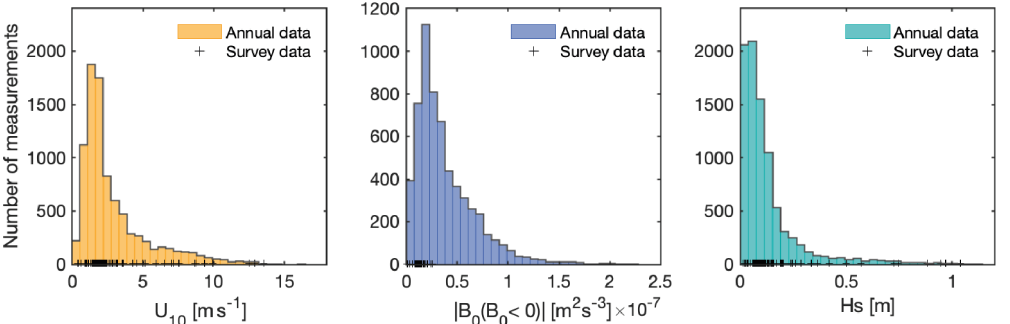
Figure 3. The annual distribution of the three main components used to compute k 600 models: wind speed at 10m (orange), buoyancy flux at the surface during cooling (blue), and significant wave height (turquoise). These survey data observed during CO 2 flux measurements after quality control ( + ) are also shown.